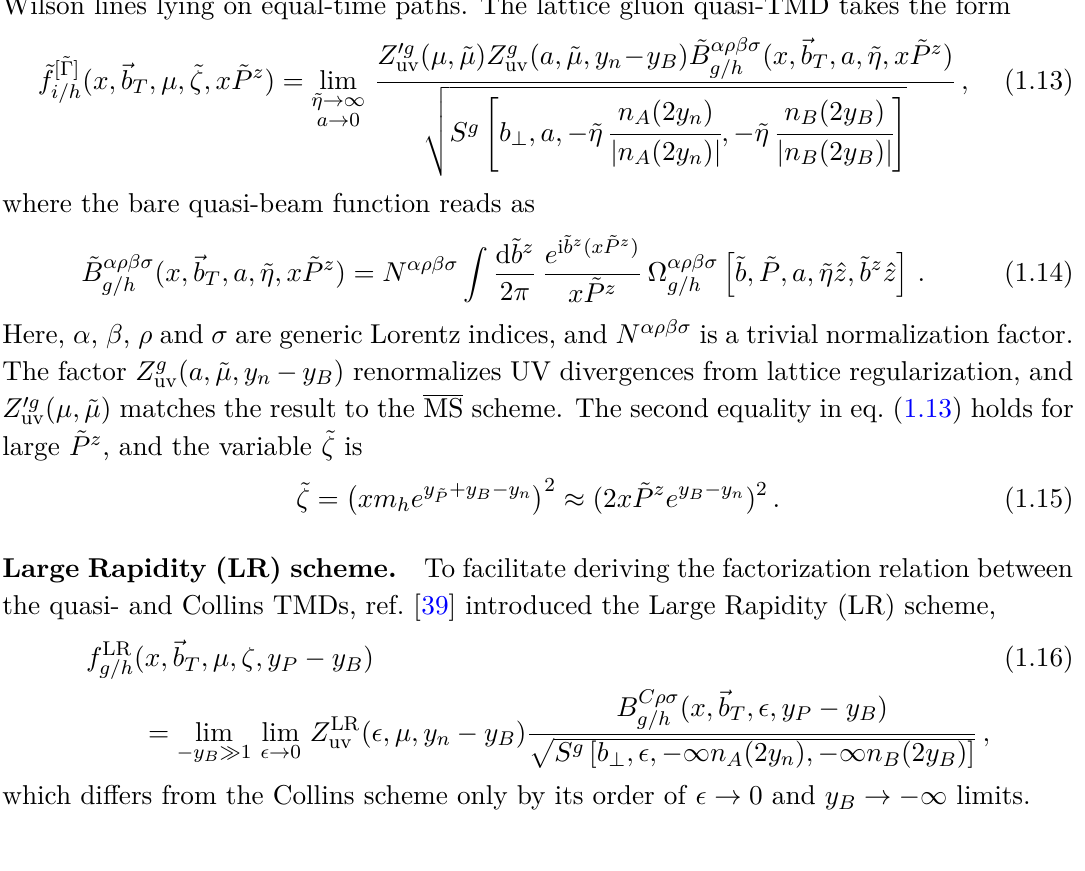
in the first UV